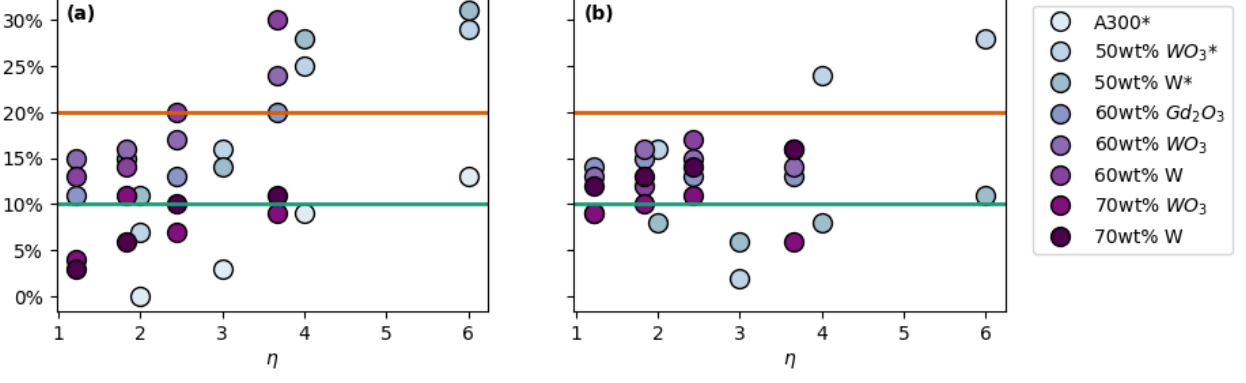
Figure 7. Relating print thickness deviation to ink density ( ρ ink ) and spacing ratios ( η ) for: ( a ) FCT prints and ( b ) SC prints. Darker colors represent higher ink densities, and lighter colors represent lower ink densities. * Data in plot ( a ) from Brounstein et al.